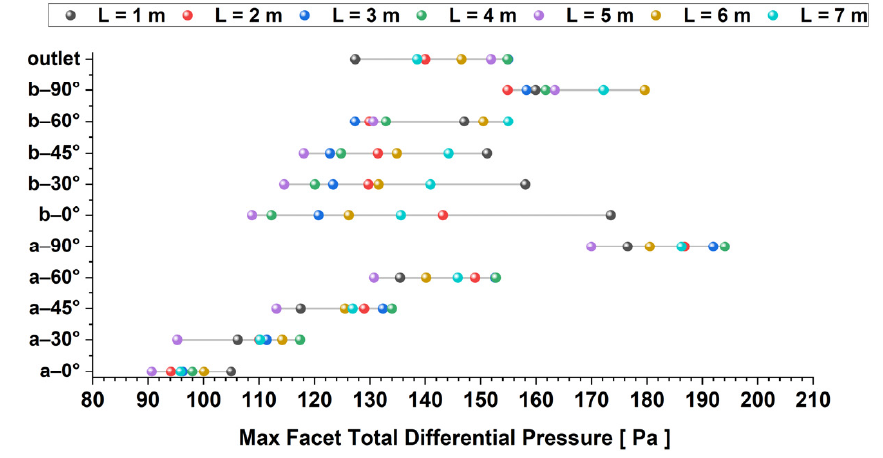
Figure 5. Max Facet Total Differential Pressure.